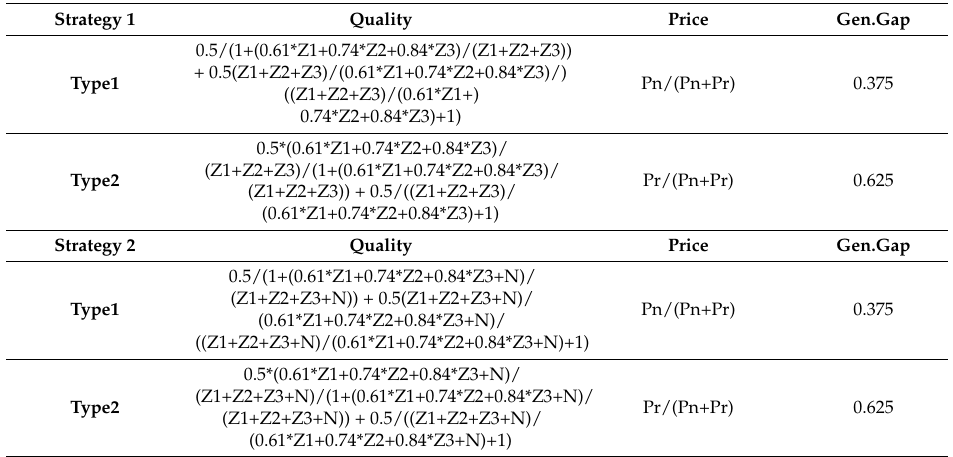
Table 5. Consistency of the performance of two types of products under two acquisition